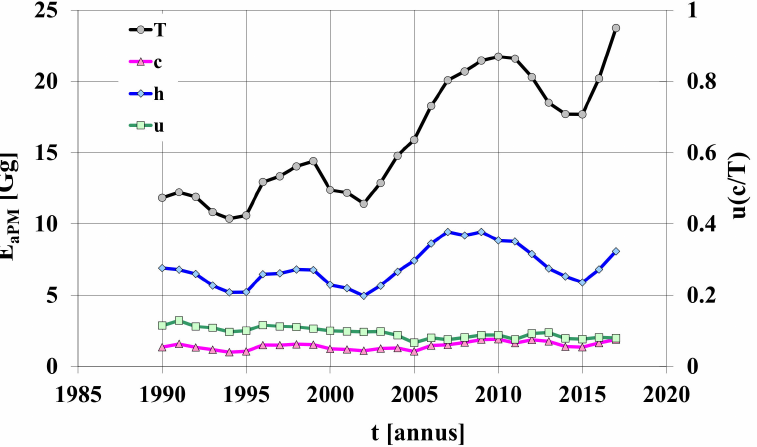
Figure 4. Annual emission of particulate matter—E aPM : national (total)—T, from car engines at cold-start—c, from car engines at warm-up—h and the share of additional emissions in the time of engine heating in total